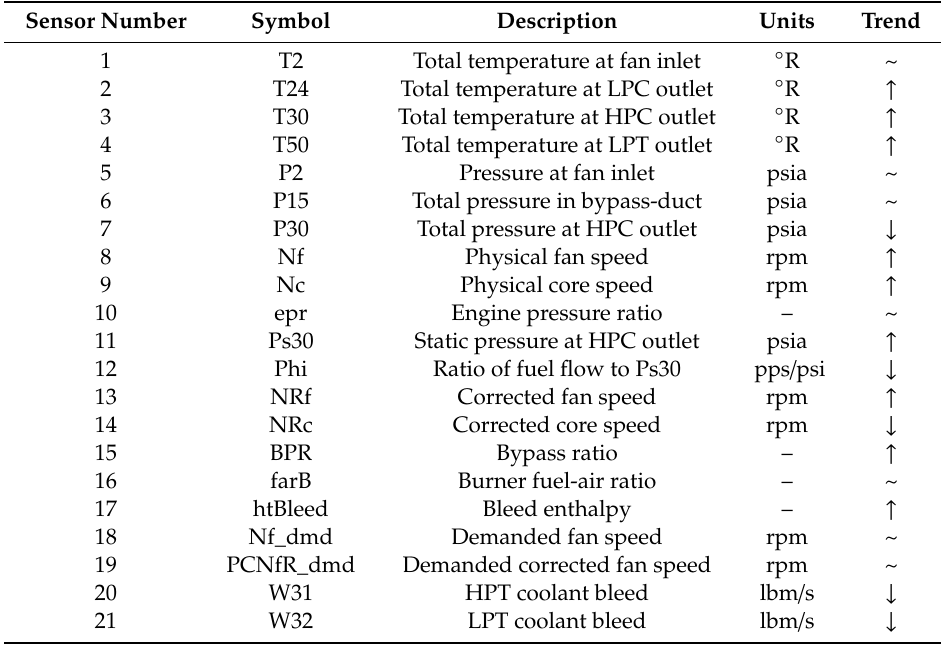
Table 2. List and physical meanings of the C-MAPSS dataset.